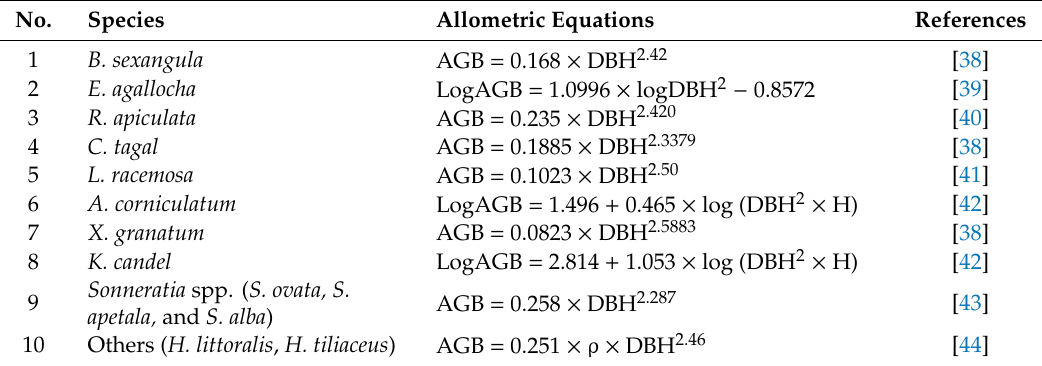
Table 2. Allometric equations for mangrove species used in this